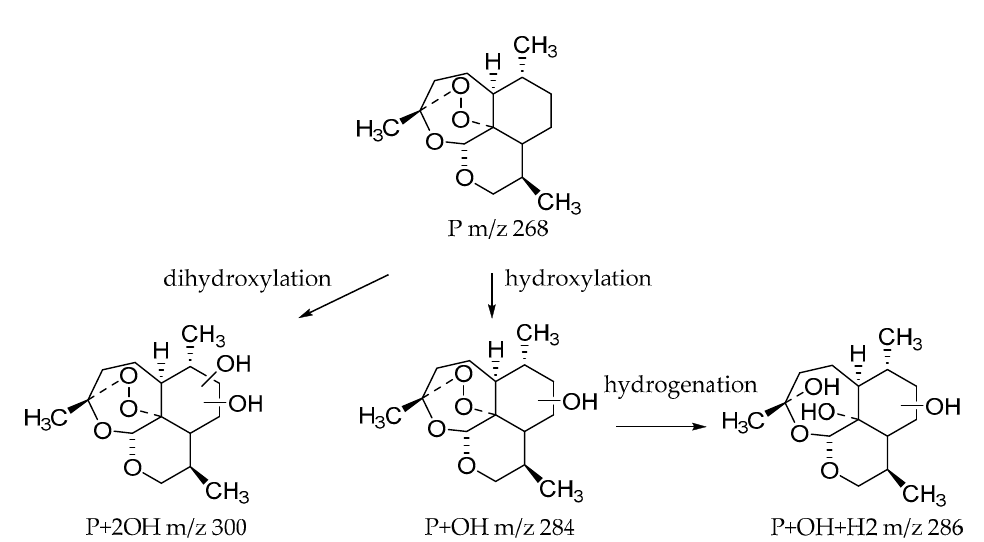
Figure 4. Structures of predicted transformation products.